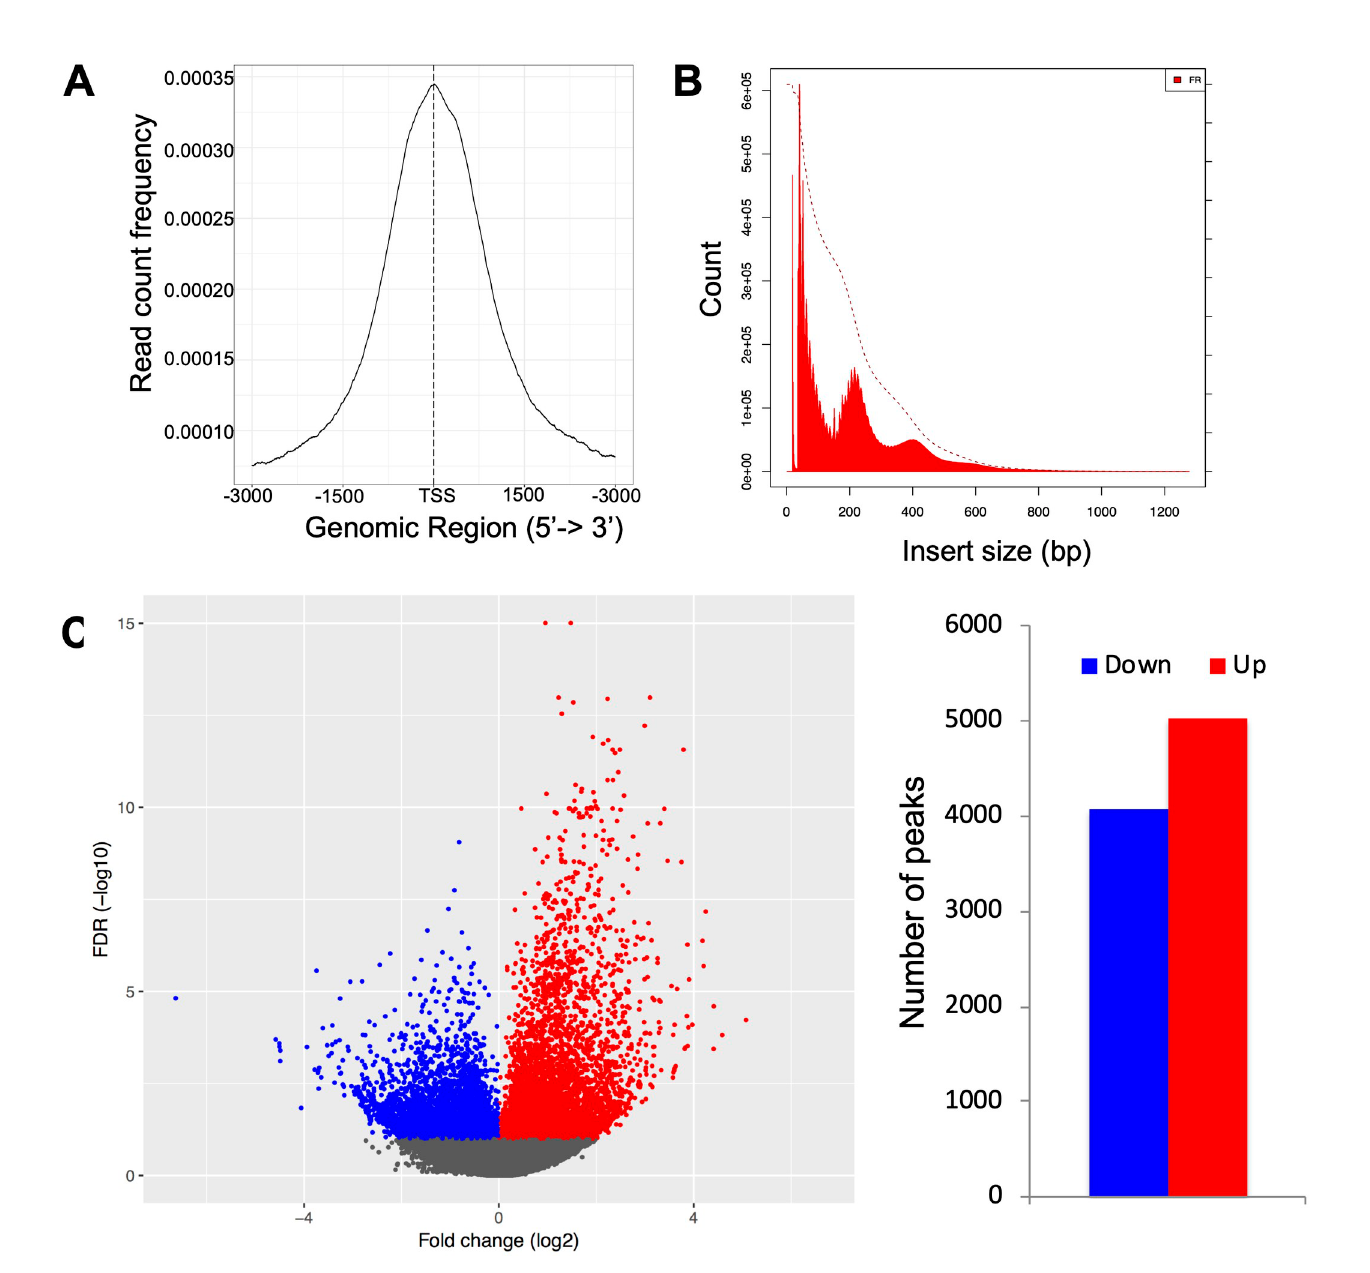
Fig 2. Latently infected cells are epigenomically distinct from actively infected cells. HIV-GFP infected cells at 12 wpi were flow sorted into GFP- and GFP + populations and analyzed by ATACseq. A. Alignment of the reads to the human genome demonstrates enrichment of reads near transcriptional start sites (TSS). B. Size distribution of library fragment sizes showing nucleosomal laddering. C . Differentially accessible regions of the cellular genome were identified and fold change versus false discovery rate (FDR) displayed as a volcano plot. Peaks that are significantly (FDR < 0.1) more open in GFP+ cells (“up”) are indicated in red, while peaks that are significantly more open in latently infected cells (“down”) are indicated in blue. The data represents an aggregate of infected cells from two independent